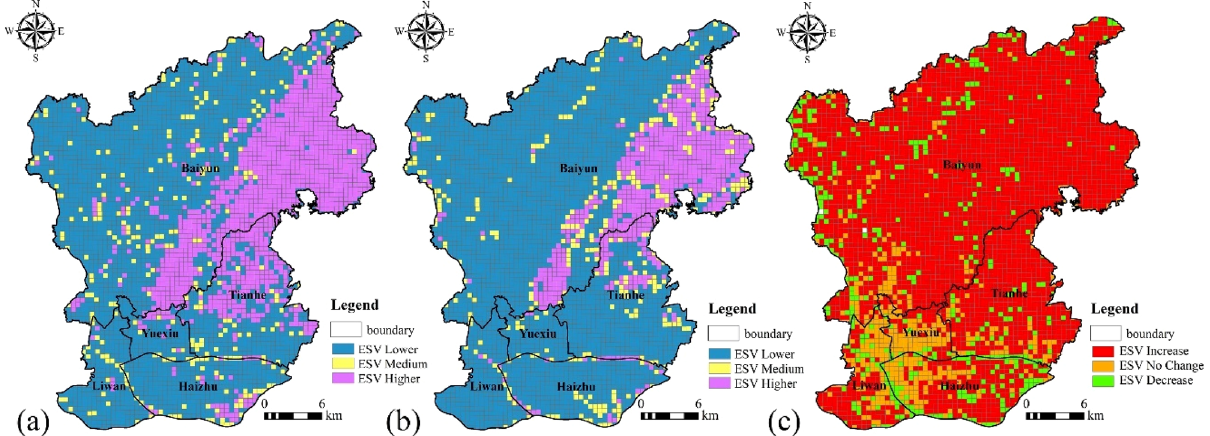
Figure 9. Changes in ESV based on a 0.5 km × 0.5 km grid between 1987 and 2017. (Software: Arc Map 10.5.0, http://www.esri.com). Service